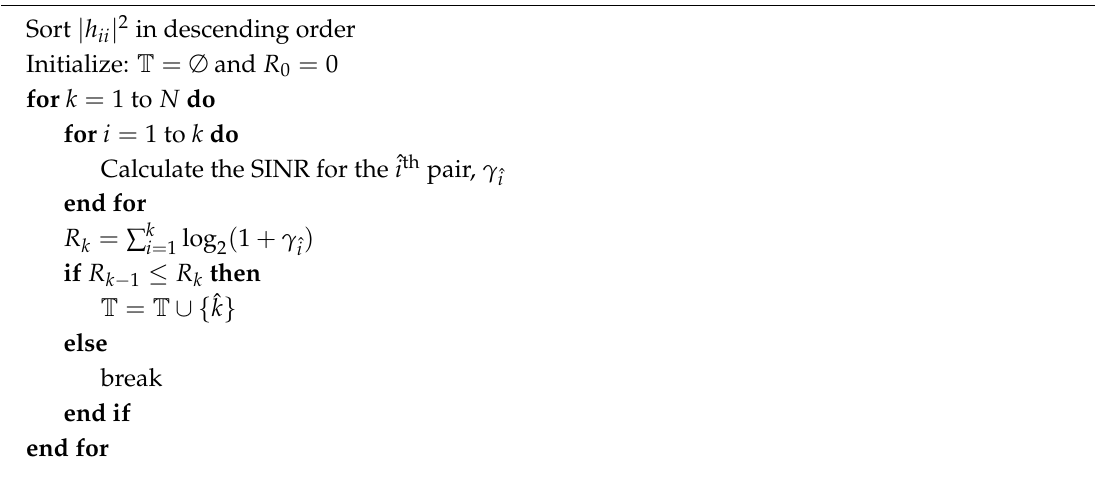
Algorithm 1 A sub-optimal algorithm to obtain training